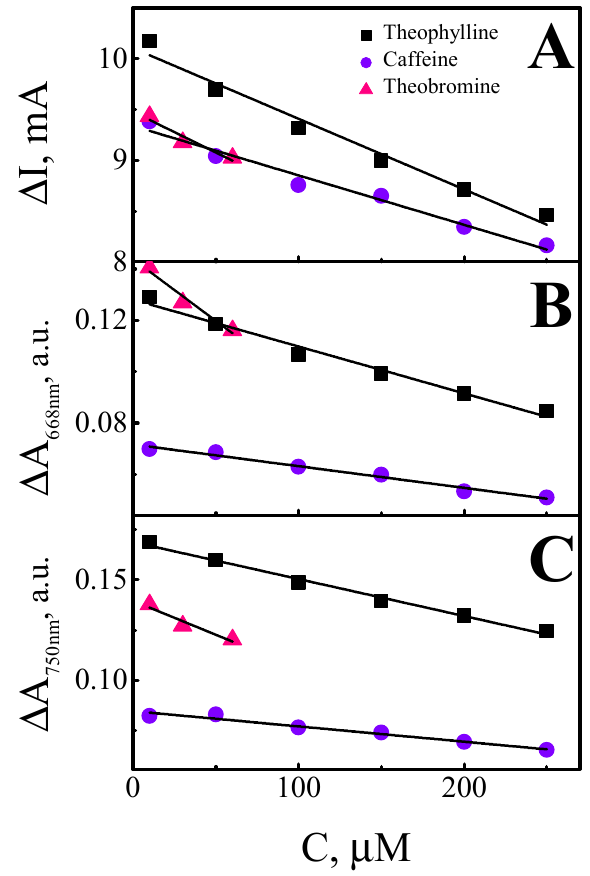
Figure 7. Dependence of absorbance changes (at λ = 668 nm and λ = 750 nm) on the concentration of caffeine, theophylline, and theobromine in BRB with 0.1 M of KCl, pH 2.5 solution. ( A )—calibration curves of ∆ I vs. concentration of caffeine, theophylline, and theobromine, ( B )—calibration curves of ∆ A (at 668 nm) vs. concentration of caffeine, theophylline, and theobromine, ( C )—calibration curves of ∆ A (at 750 nm) vs. concentration of caffeine, theophylline, and theobromine. Table 2. Dependence of absorbance changes (at λ = 668 nm and λ = 750 nm) on the concentration of caffeine, theophylline, and theobromine. The slope and intercept values of the calibration curves. Slope Intercept R 2 Theophylline − 0.007 ± ∆ I